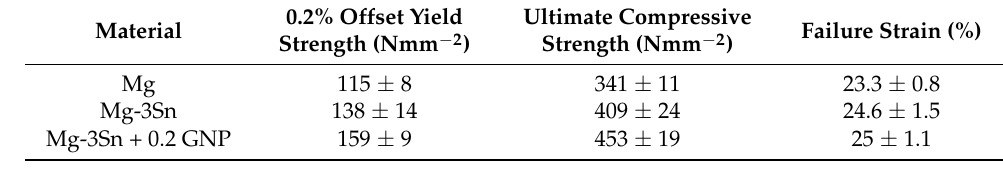
Table 3. Compressive properties at room temperature (24 °C).